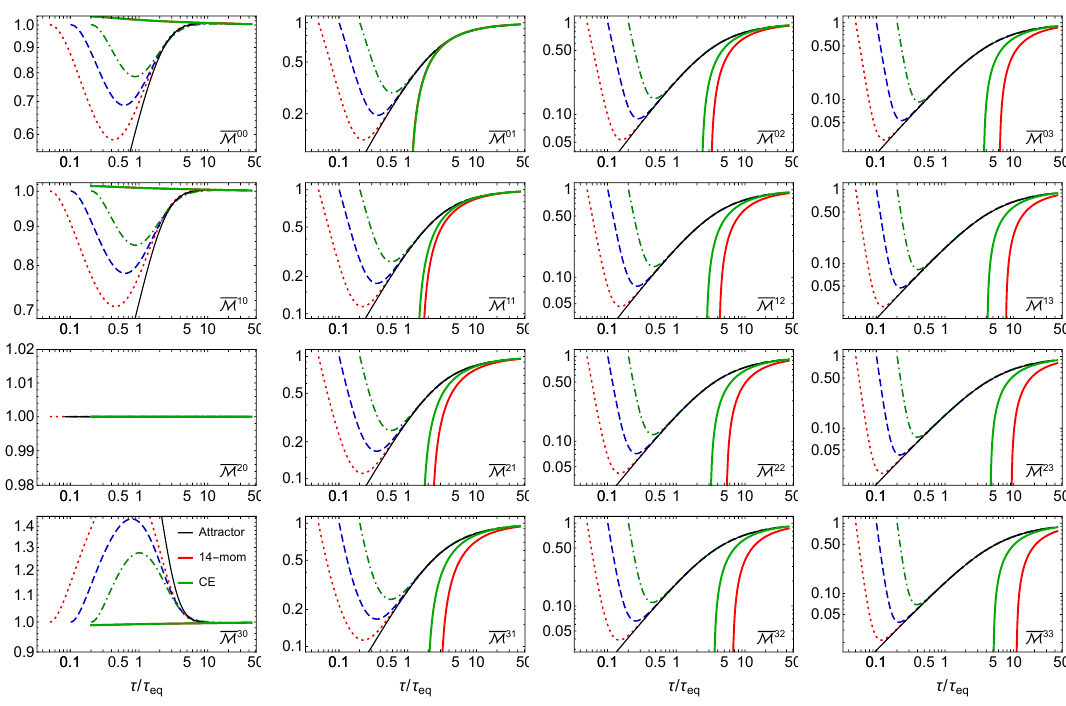
Figure 3 . Scaled moments M nl as a function of rescaled time for the case m = 0 . 2 GeV. The non-solid lines are specific initial conditions initialized with T 0 = 1 GeV and ξ 0 = 0 at τ 0 ∈ { 0 . 01 , 0 . 02 , 0 . 04 } fm/c. Line styles are the same as in figure